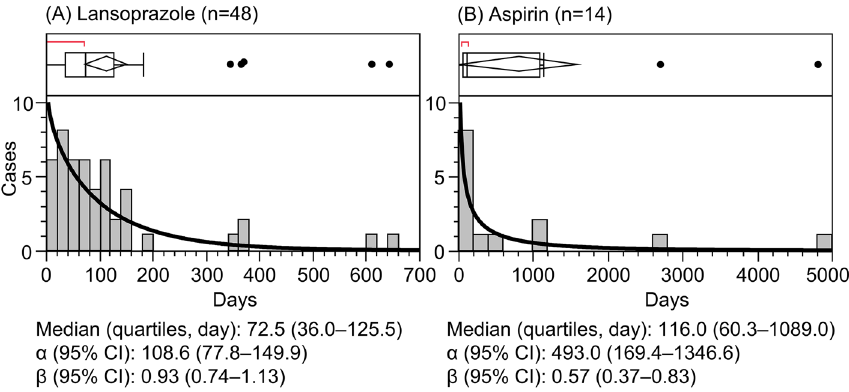
Figure 3. Histograms and Weibull shape parameters of microscopic colitis for ( A ) lansoprazole and ( B )